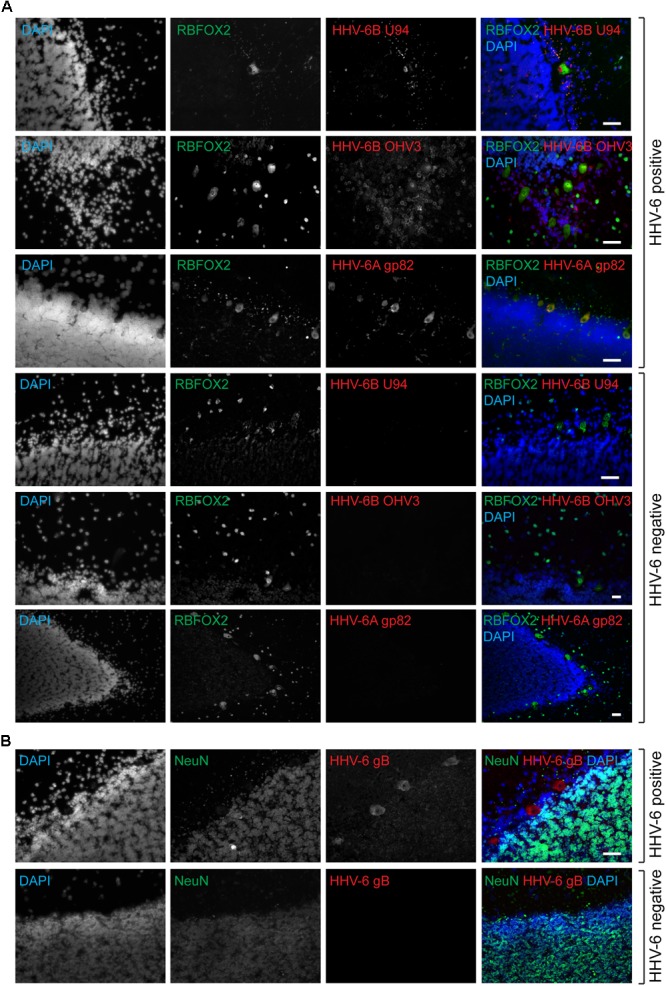
Active HHV-6 infection in Cerebellum of mood disorder patients. (A) Representative images showing Immuno-fluorescence analysis for HHV-6 viral antigens in cerebellar cortex samples. Cryo-sectioned cerebral cortex samples were stained using antibodies raised against different HHV-6 antigens (gp82/105, U94, and OHV3) together with either RBFOX2 (Fox2; marker for Purkinje cells). Representative samples without HHV-6 infection (negative control) are also shown in the lower panel. (B) Purkinje cell specific HHV-6 staining was tested using antibodies against NeuN (marker for other neuronal cells). Each panel shows results from a different case. DAPI was used to stain DNA. The scale bars (indicated with white lines) represent 200 μm.